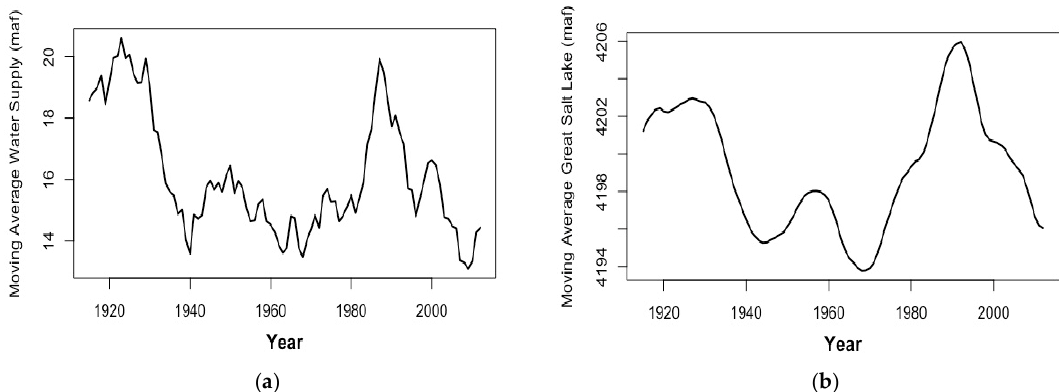
Figure 9. Plot of the 10-year moving-average water supply in million acre feet (maf) of the Colorado River ( a ) and plot of the ten-year moving average of Great Salt Lake water level ( b